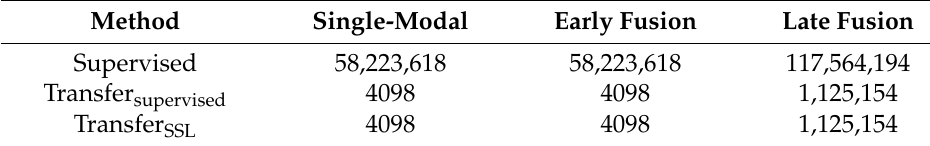
Table 5. Number of trainable parameters.